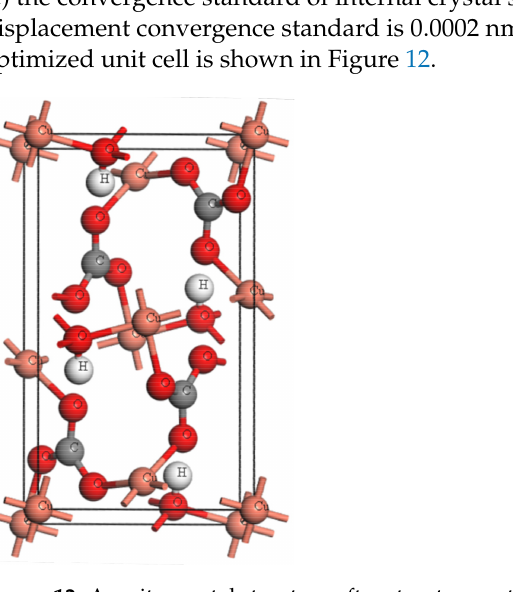
Figure 12. Azurite crystal structure after structure optimization.